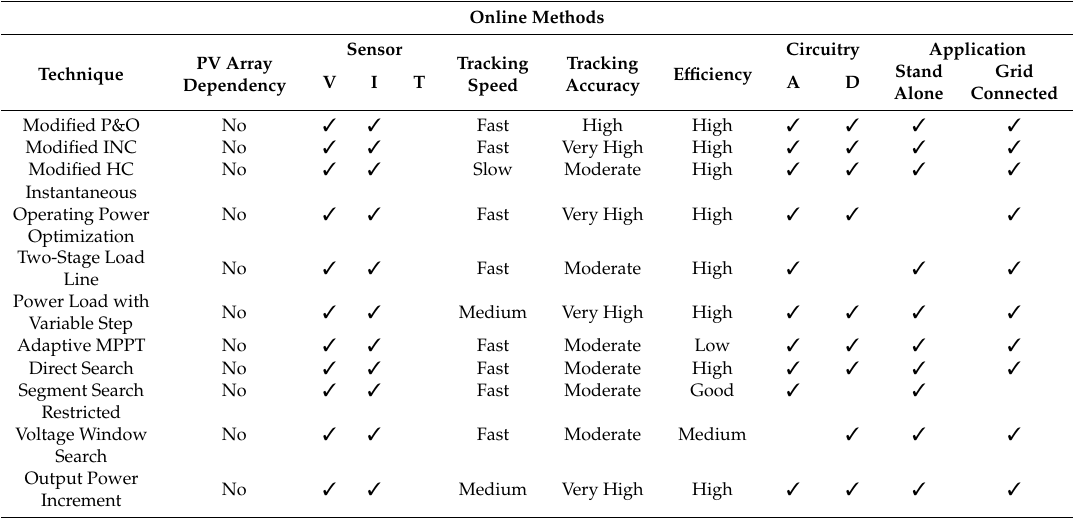
Table 2. Comparison of online maximum power point techniques under non-uniform solar irradiance.